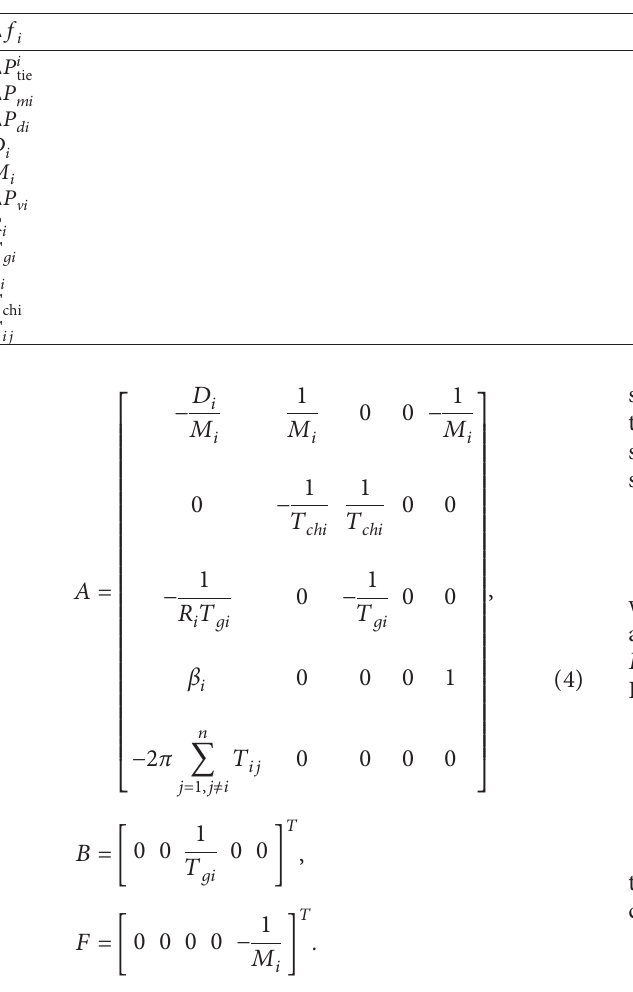
Figure 1: The model of the i th area of the power system. Table 1: Definition of